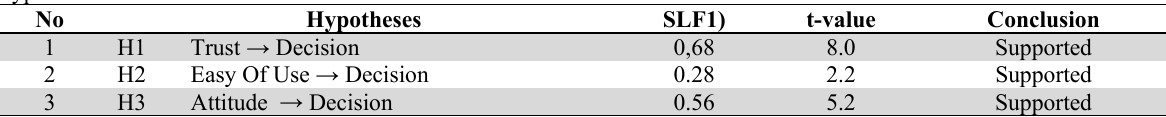
Hypotheses test